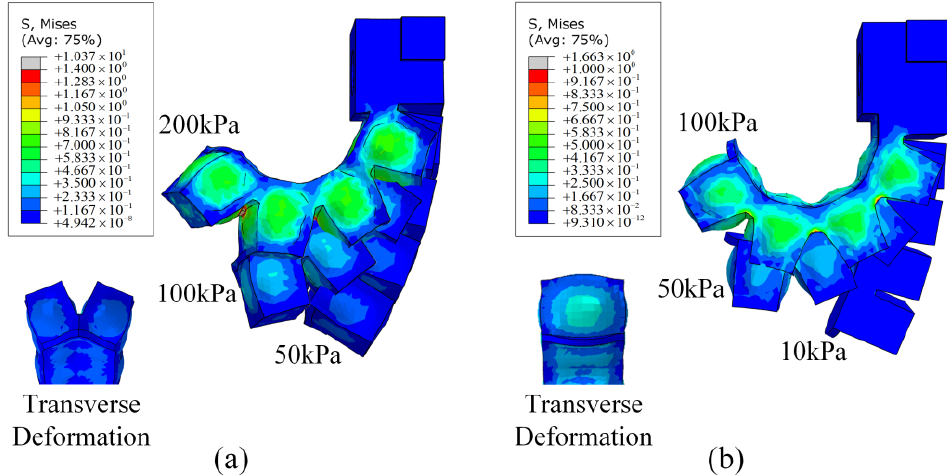
Figure 3. FE simulation results of ( a ) the herringbone actuator and ( b ) the regular actuator.